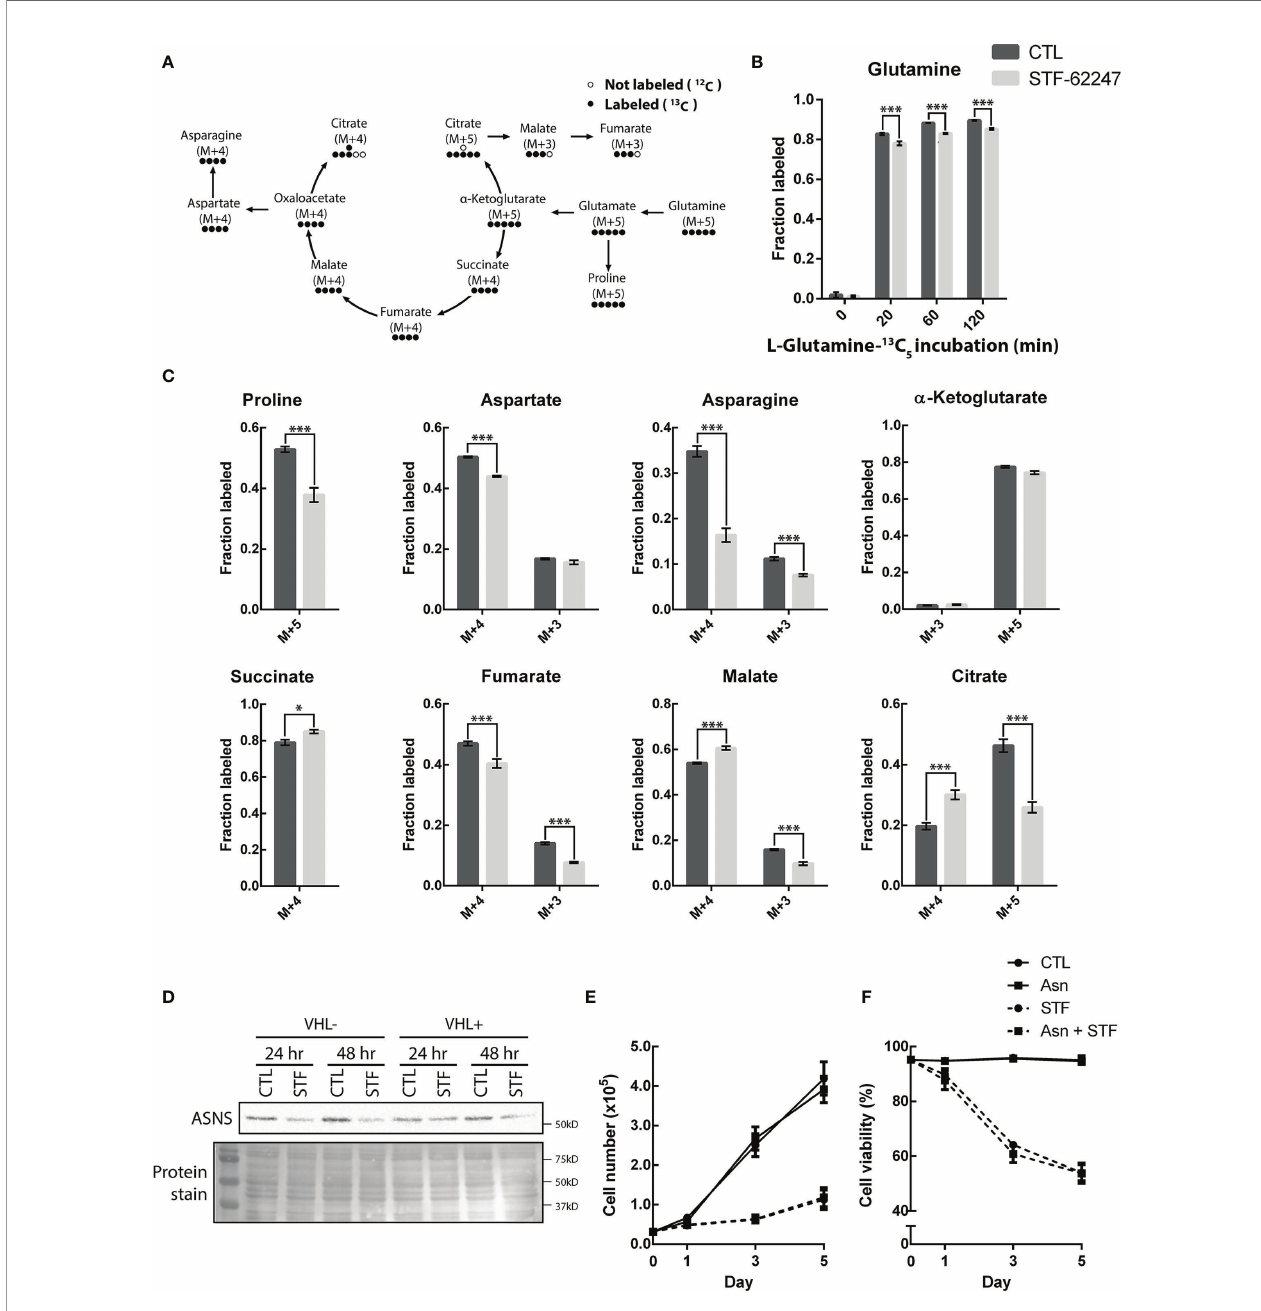
FIGURE 4 | STF-62247 causes a shift in glutamine metabolic fl ux and increases the use of the oxidative TCA cycle. (A) Simpli fi ed schematic representation of the carbon exchange in glutamine metabolism. Arrows do not always represent direct metabolic reactions. (B) L-Glutamine-13C5 incorporation, assessed by GC-MS, in RCC4 VHL- untreated and treated with 1.25 µM STF-62247 for 24 hr (N=3). (C) Metabolites fractions labeled from L-Glutamine-13C5 (120 min incubation) in RCC4 VHL- untreated or treated with STF-62247 for 24 hr (N=3). Metabolites derived from oxidative TCA: Succinate M+4, Fumarate M+4, Malate M+4, Aspartate M+4, Asparagine M+4, Citrate M+4, a -Ketoglutarate M+3. Metabolites derived from reductive TCA: Citrate M+5, Malate M+3, Fumarate M+3, Aspartate M+3 and Asparagine M+3. (D) Immunoblot analysis of asparagine synthetase (ASNS) in RCC4 VHL- and VHL+ after 24 hr and 48 hr of STF-62247 treatment. (E) Proliferation (F) and viability of RCC4 VHL- treated with 1.25 µM STF-62247 and/or 2 mM Asparagine (Asn). Cells were counted on days 0, 1, 3 and 5 with trypan blue to evaluate cells viability (N=3). Statistical marks shown in cell proliferation and viability curves are either between CTL and Asn, or between STF and STF + Asn conditions. Results are presented as means and SEM of three independent experiments. Statistical analyses (Two-Way ANOVA followed by Sidak ’ s (B, C) or Tukey ’ s test (E, F) ) were performed to assess signi fi cant differences in the results. (*p < 0.05, ***p <